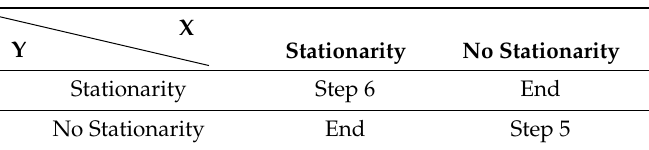
Table 2. Step selection